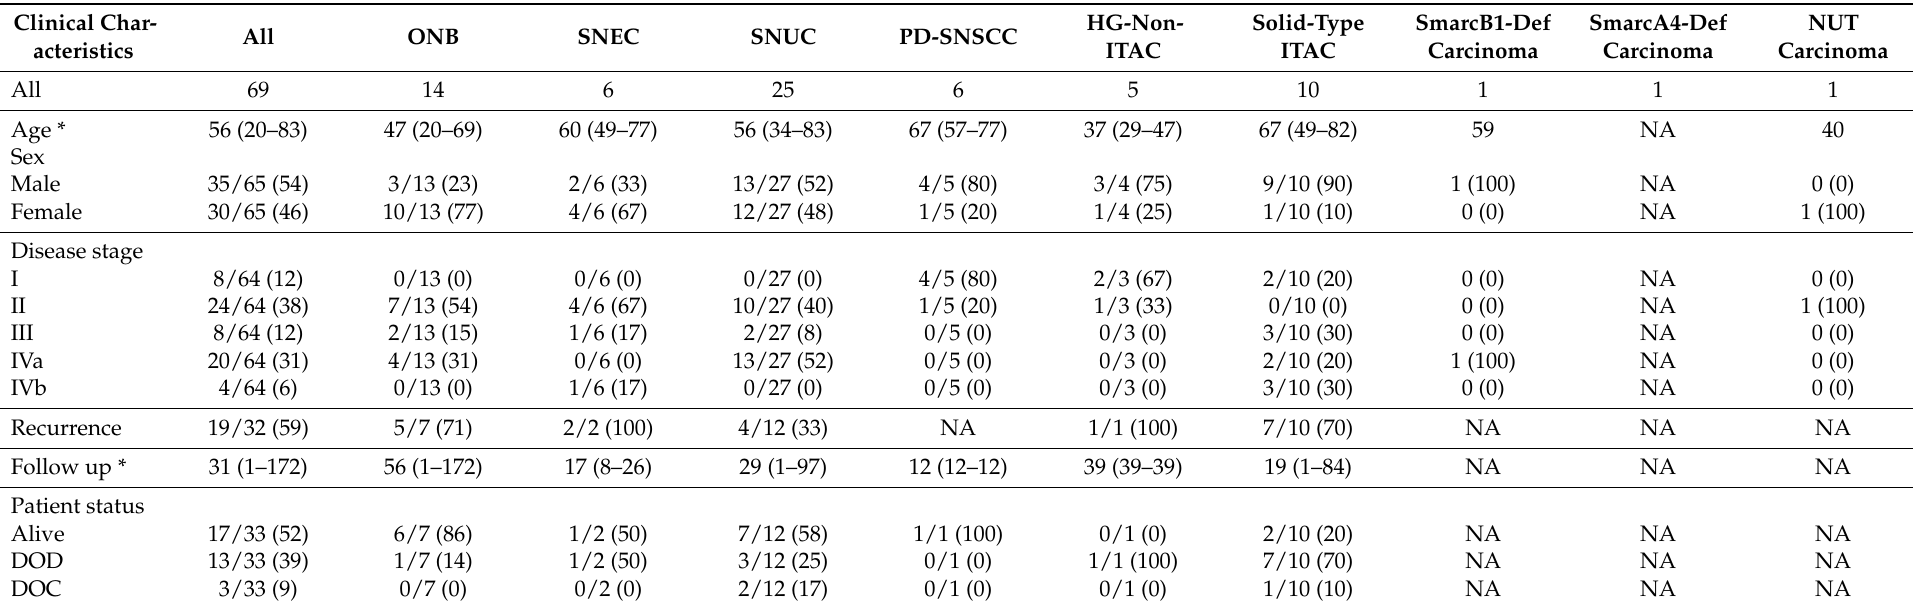
Table 1. Clinical features of all